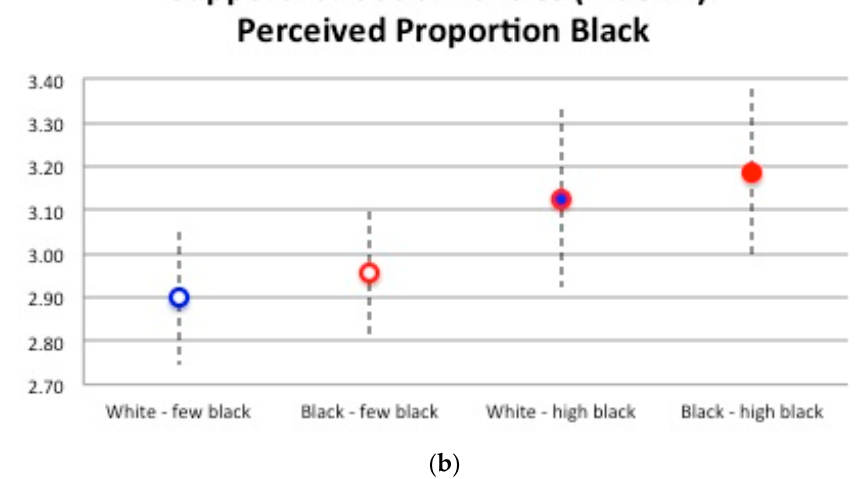
Figure 10. Predicted probabilities of support for redistribution ( a ) and social policies ( b ) by perceived proportion of blacks for white and black respondents.